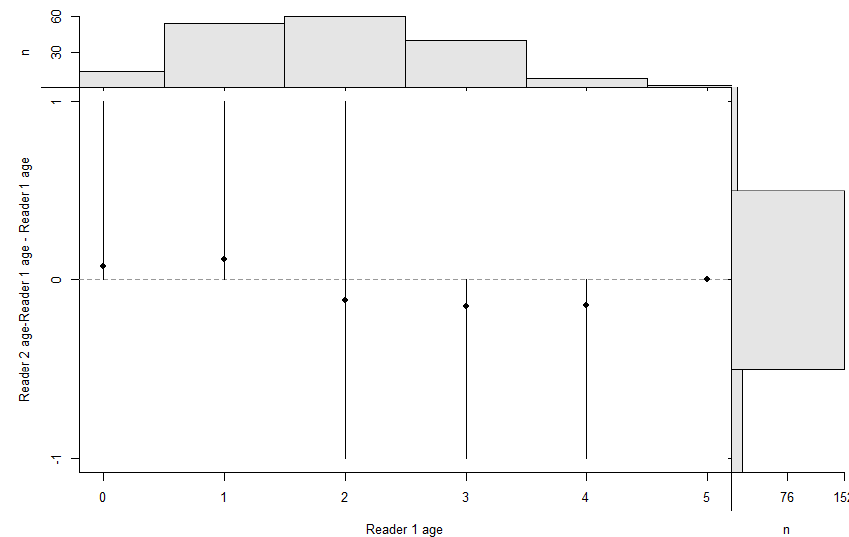
Figure 7. Age-bias plot of reader 1 estimates versus reader 2 estimates. Notes : Mean (dots) and range (intervals) of differences in otolith age are estimates between two readers at the estimates for the first reader for Chub mackerel in the northwest Pacific Ocean. The agreement line, which is the horizontal line, suggests a difference in the two age estimates from readers. Marginal histograms are for age estimates of the first reader (top) and differences in age estimates between readers (right). The bar at a difference of zero represents the amount of perfect agreement between the sets of age estimates ( n = 152).